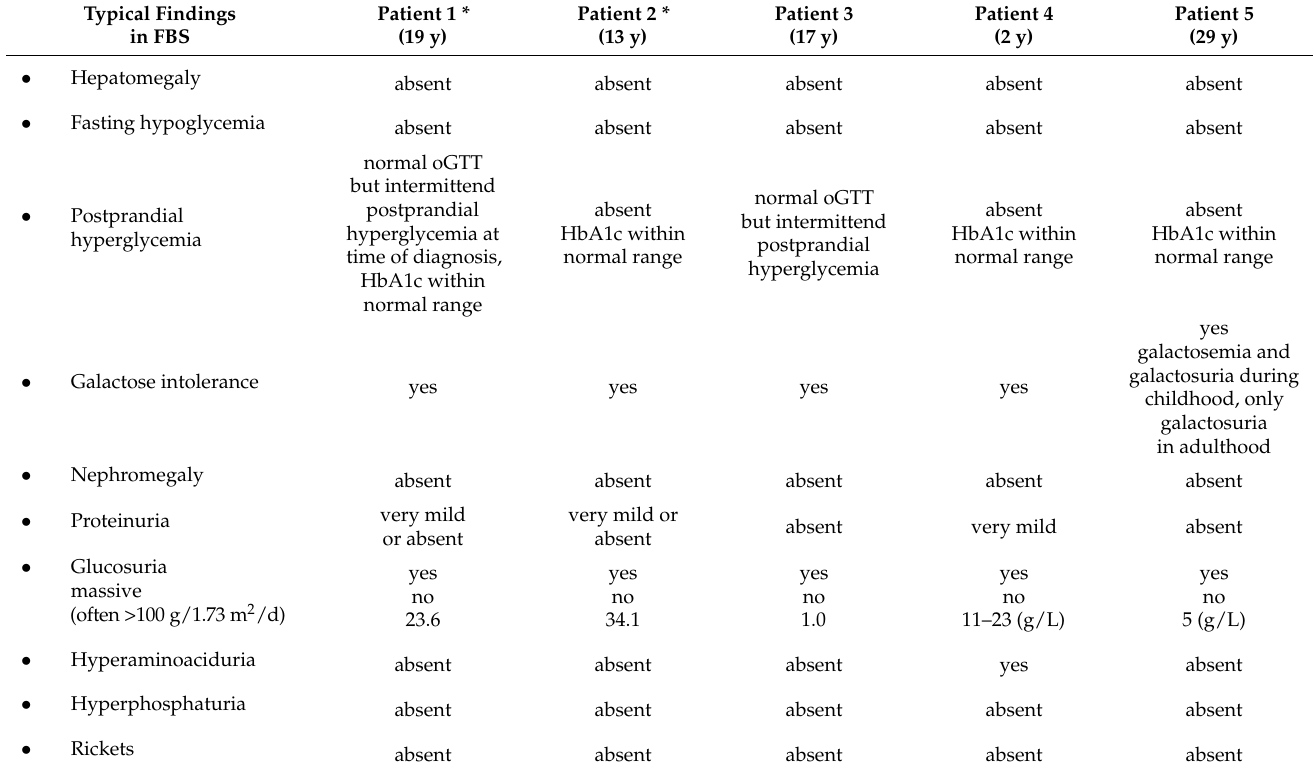
Table 1. Typical features of Fanconi-Bickel syndrome (FBS) and summary of clinical findings in patient 1–5. (* previously reported [6]); oGTT, oral glucose tolerance test. Typical Findings in